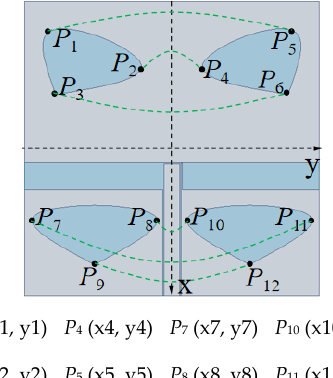
Figure 6. Symmetry analysis of the heart-shaped structure.